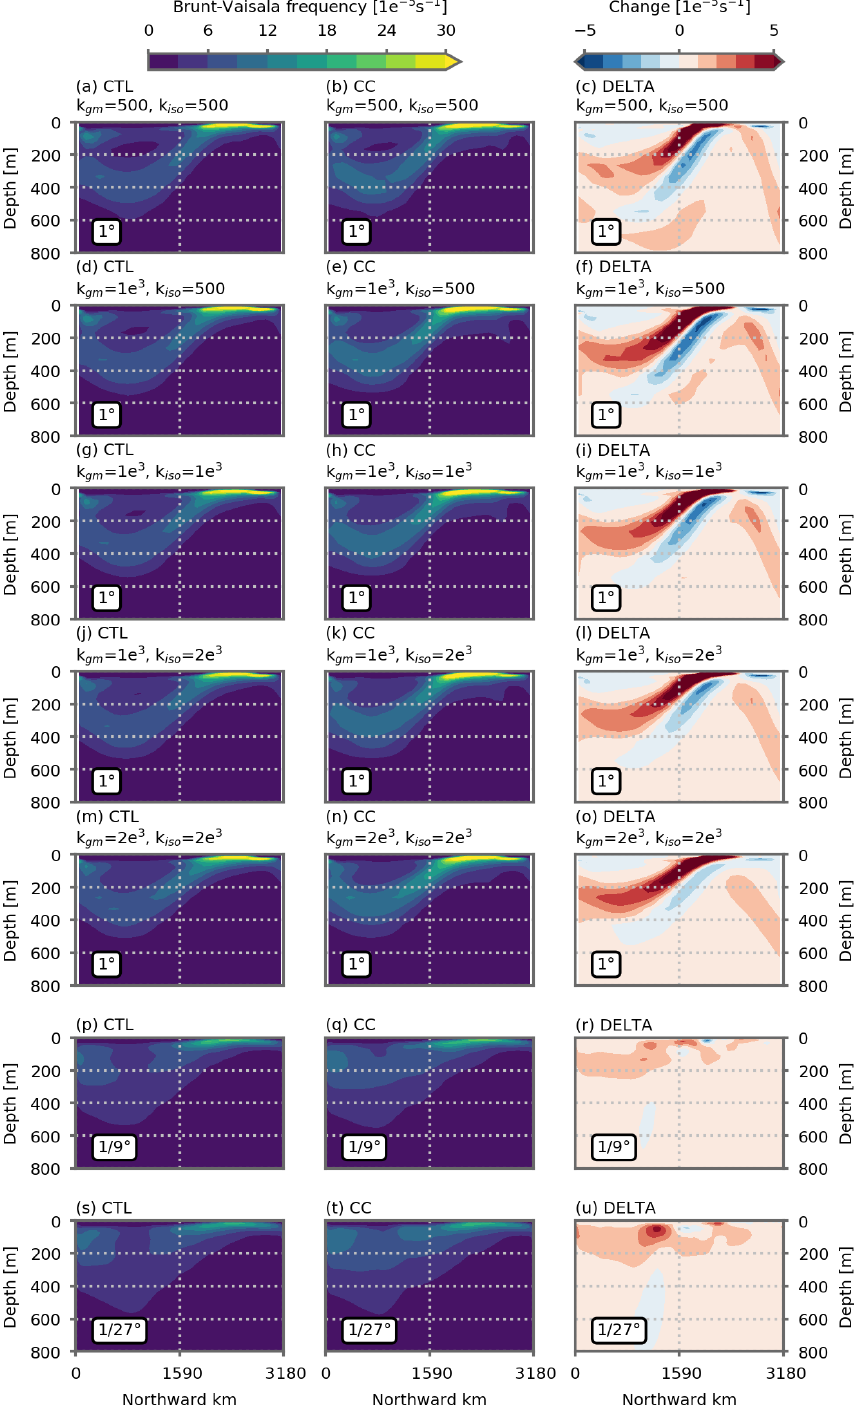
Figure A10. Vertical distribution of the Brunt–Vaisala frequency across the domain (zonal mean, 10 − 5 s − 1 ) in the preindustrial control simulations (first column) and the climate change simulations (second column) and the difference between the two (third column). Panels (a) – (o) show the five 1 ◦ resolution configurations, and (p) – (u) show the 1 / 9 and 1 / 27 ◦ resolution configurations. All figures show the average over the last 5 years of the simulations (years 66 to